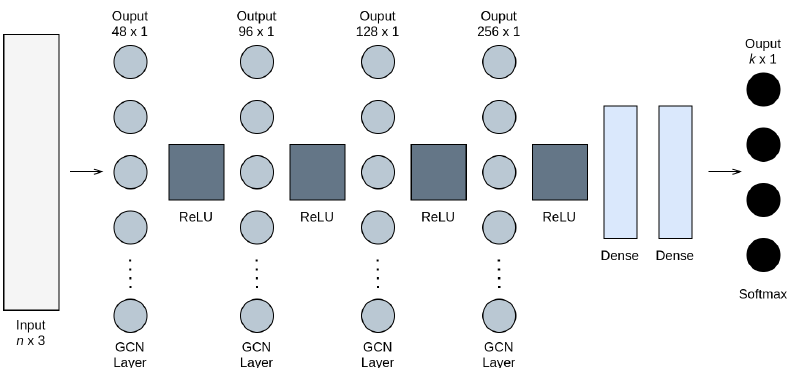
Figure 2. Structure of the deep learning network. The input layer’s dimensions are n × 3, where n is the number of UAVs in the UAV network. The output layer has k × 1 dimensions, with k being the number of